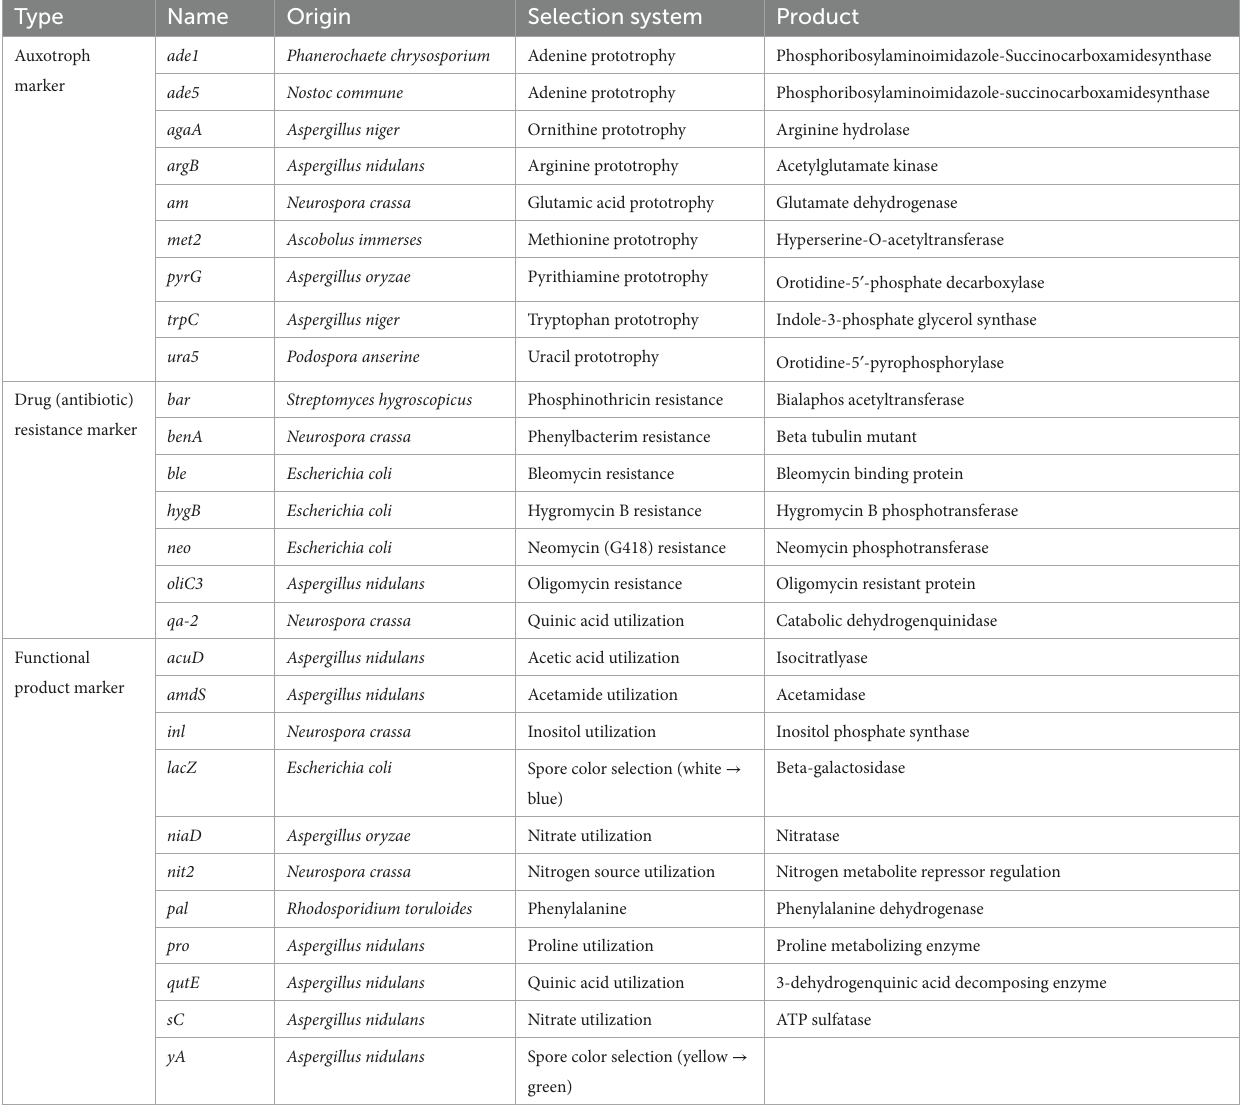
TABLE 4 Commonly used selective markers in Aspergillus